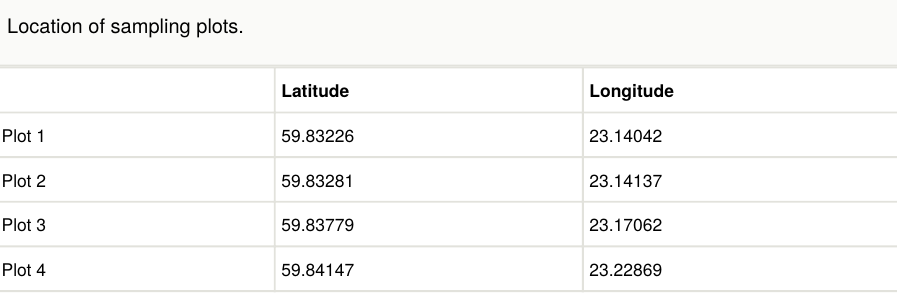
Location of sampling